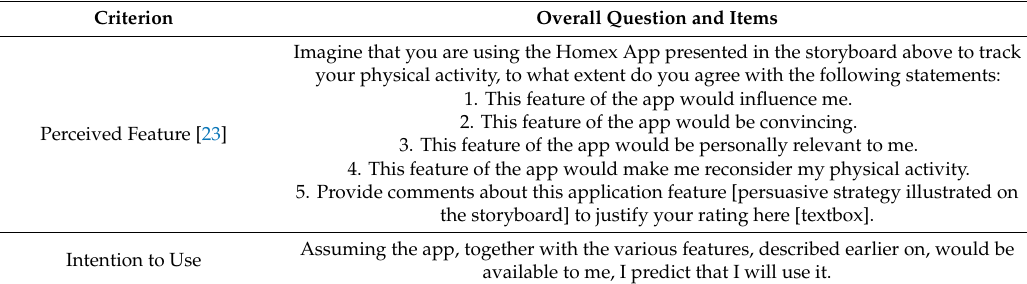
Table 2. Study’s constructs and indicators.